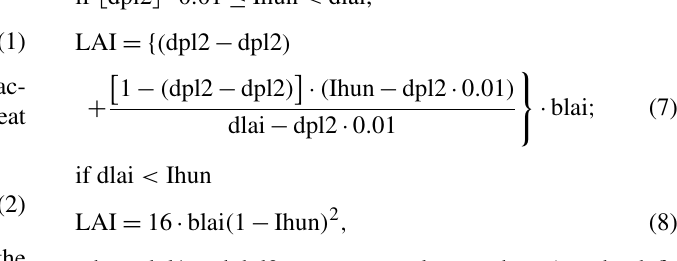
as a crop-specific